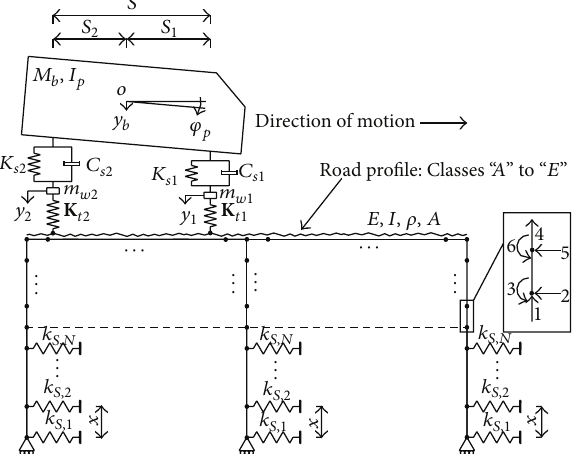
Figure 5: Continuum model of half car crossing an integral bridge (not to scale).